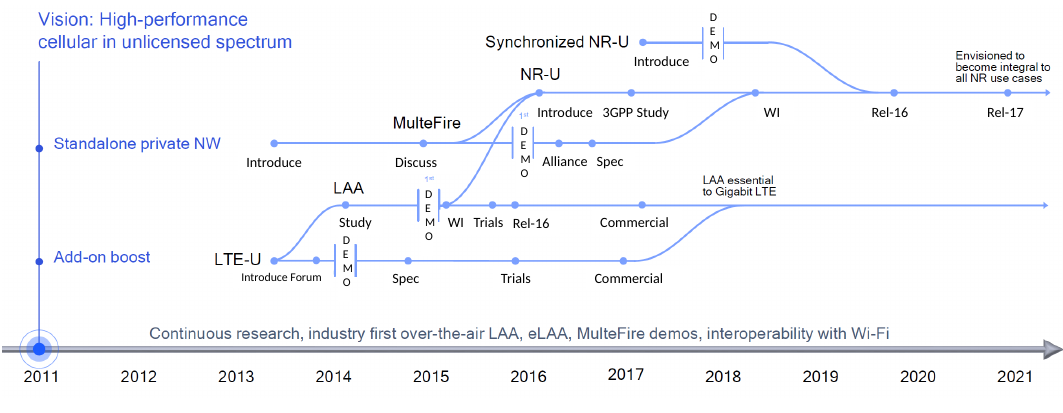
Figure 1. Evolution of NR-U [16]. eLAA, extended Licensed Assisted Access.